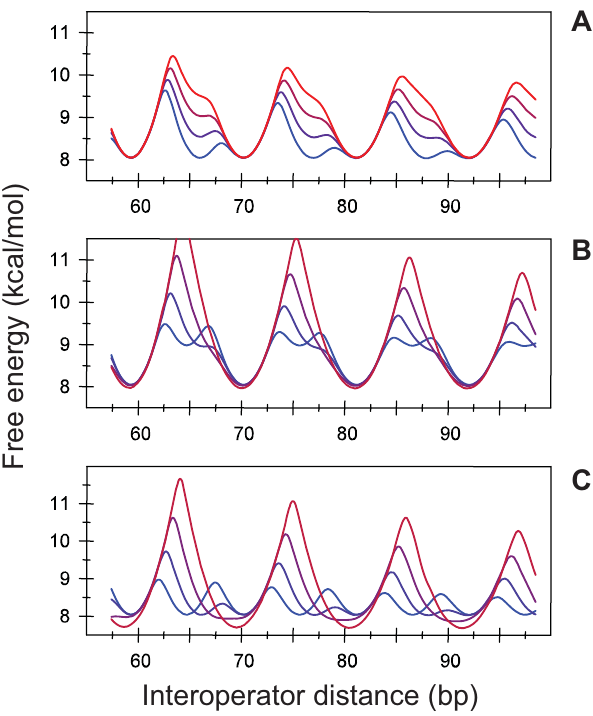
Figure 3. Free energy of looping for a two-conformation elastic DNA model. Different types of behavior are obtained by changing two key parameters: the difference in optimal free energies ( D G 0,1– D G 0,2 ) and optimal phases ( L opt ,1 – L opt ,2 ). (A) The difference in optimal free energies between the two configurations increases from 0 kcal/mol (blue) to 1.5 kcal/mol (red) in increments of 0.5 kcal/mol whereas the difference in optimal phases is kept fixed at 4.2 bp. (B, C) The difference in optimal phases between the two conformations increases from 2 5.5 bp (blue) to 0 bp (red) in increments of 5.5/3 bp whereas the difference in optimal free energies is kept fixed at 1 kcal/mol (B) and at 0 kcal/mol (C).